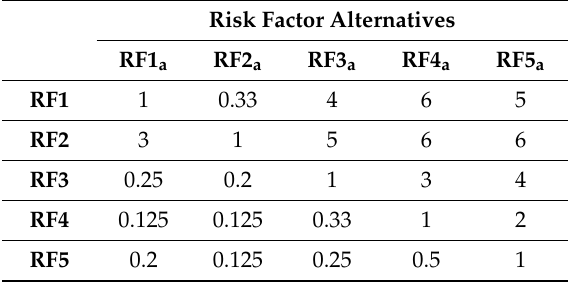
Table 1. Aggregate pairwise comparisons matrix.